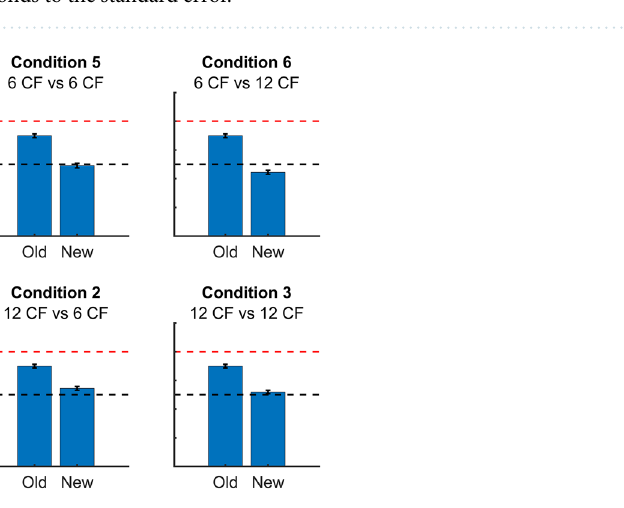
Figure 3. Learning curves of both groups of animals, averaged across animals. The left graph shows the learning curves of the animals that received the training stimuli in the order as presented in Fig. 8a, which were 6 rats in total, whereas in the right graph, the animals, 4 in total, received the stimuli in reversed order. The red dashed line represents the 80% performance threshold, whereas the black dashed line represents chance level. The shaded error bar corresponds to the standard error.